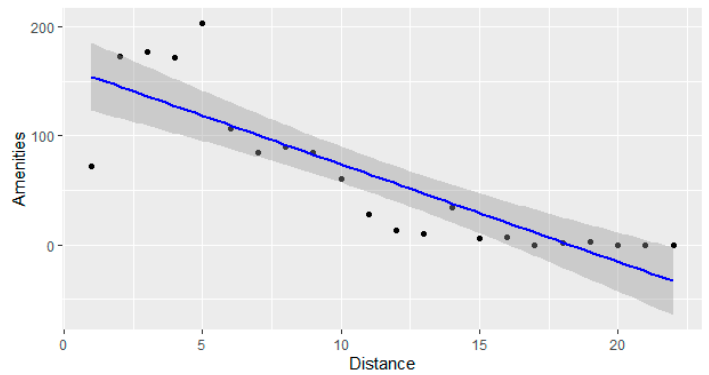
Figure 13. Urban amenities distribution regression (blue line) at a prediction interval of 95% against distance from the city center. Medium gray is for the prediction interval, where future observations could fall, and black circles are for the total count of assorted amenities at every one-kilometer distance from the